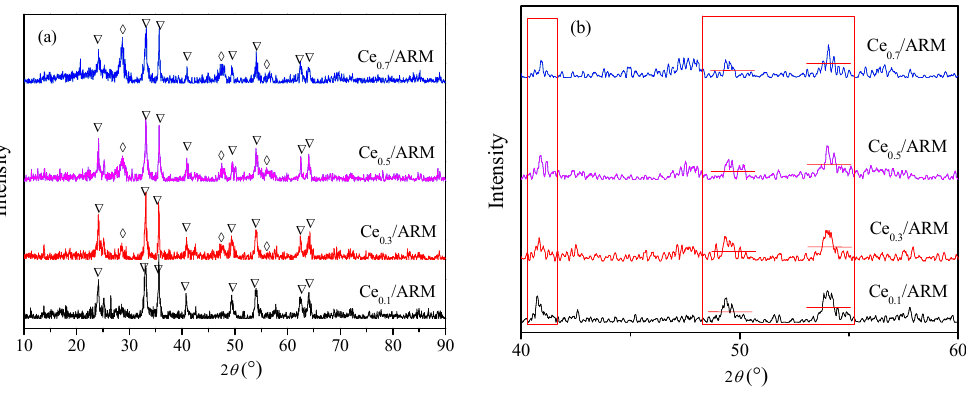
Figure 7. XRD patterns of Ce/ARM catalyst. ( a ) Complete patterns ( ▽ : α‐ Fe 2 O 3 ◊ : CeO 2 ); ( b ) local patterns.